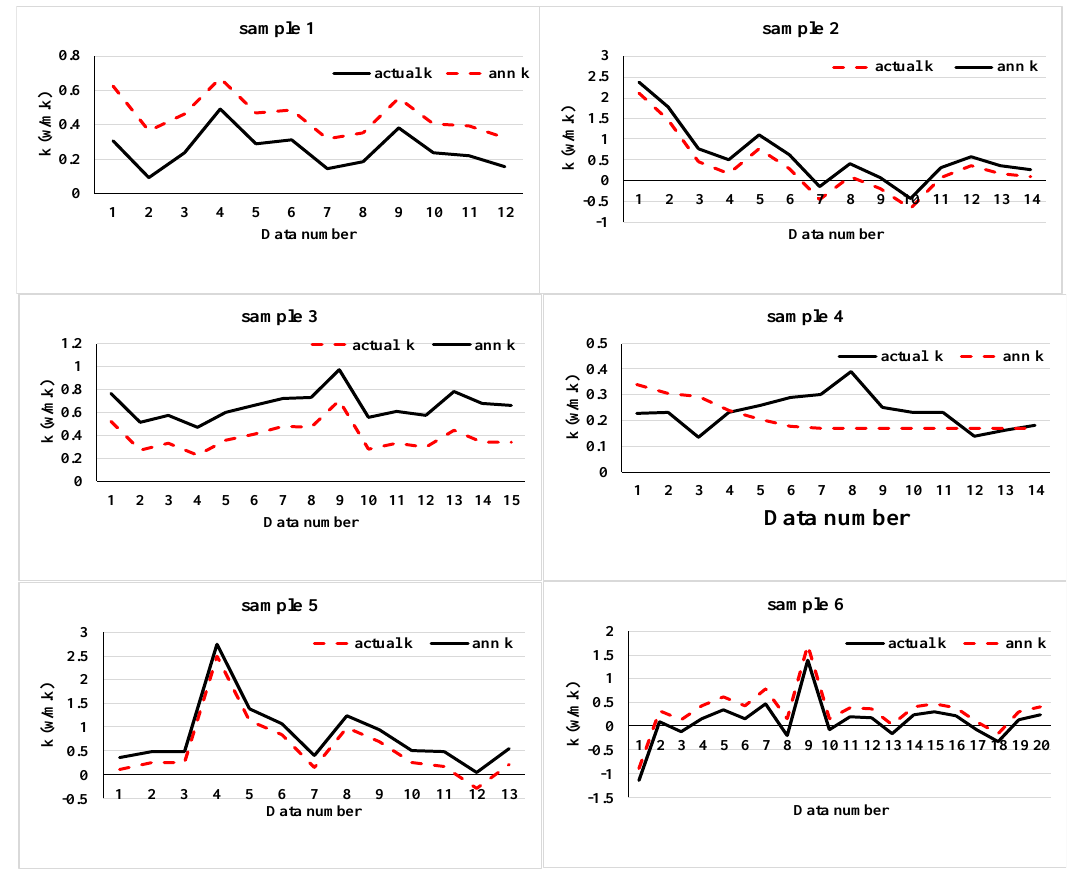
Figure 5. Thermal conductivity validation plots of ANN end experimental data.